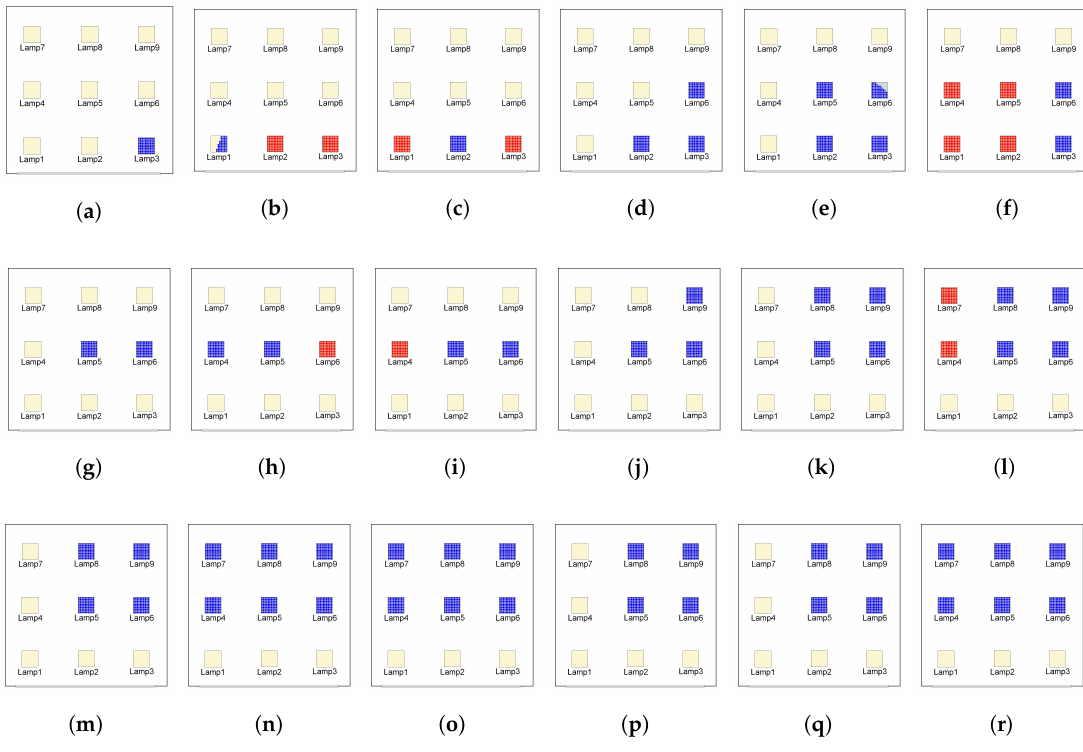
Figure 5. LEDs viewed from the receiver’s position: ( a ) S1; ( b ) S2; ( c ) S3; ( d ) S4; ( e ) S5; ( f ) S6; ( g ) S7; in Table 1. Blue points represent the LEDs viewed by the receiver with an FOV of 20 ◦ . Red points represent the LEDs viewed by the receiver, in addition to the blue ones, when the receiver has an FOV of 180 ◦